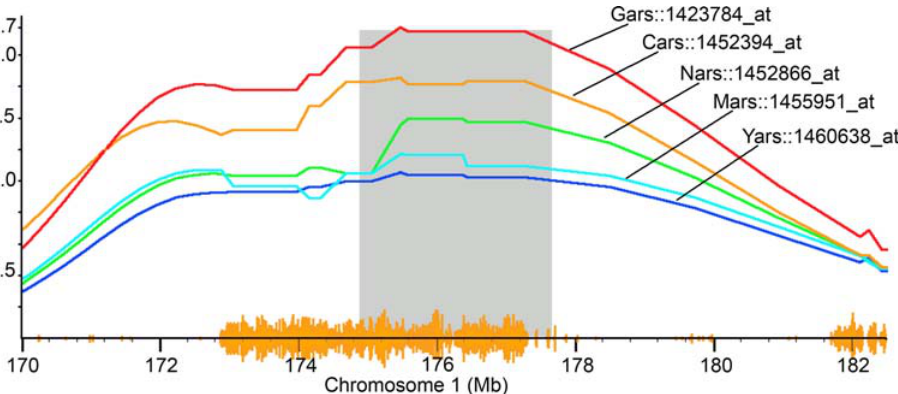
Figure 5. QTL for aminoacyl-tRNA synthetases in distal Qrr1 . Transcripts of Gars , Cars , Nars , Mars , and Yars map as trans -QTLs to Qrr1 at LOD . 4 (genome-wide p -value , 0.01) in the BXD hippocampus dataset. The trans -QTLs have peak LOD precisely on markers in distal part of Qrr1 , , 175–177.5 Mb (shaded regions). Yellow seismograph on Chr 1 (x-axis) tracks SNP density between B and D alleles. Affymetrix probe set ID for each transcript is shown.